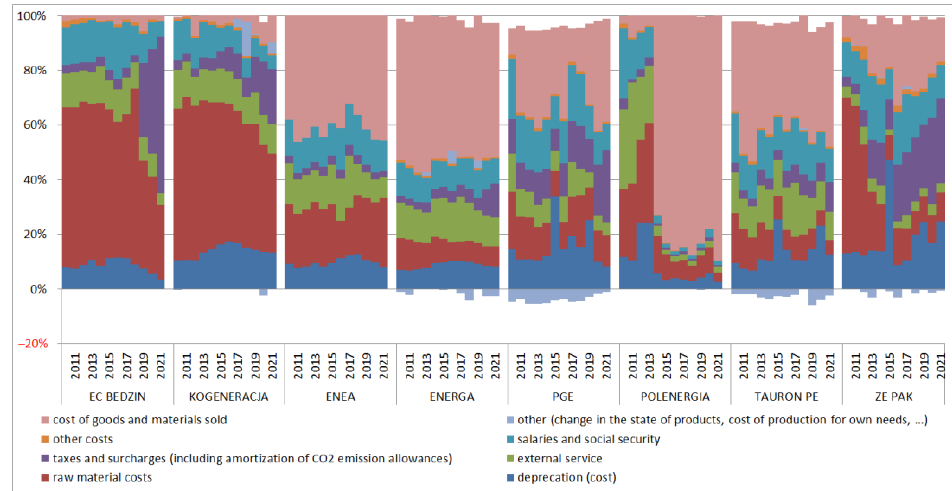
Figure 6. Structure of generic costs of the surveyed energy companies. Source: own elaboration.